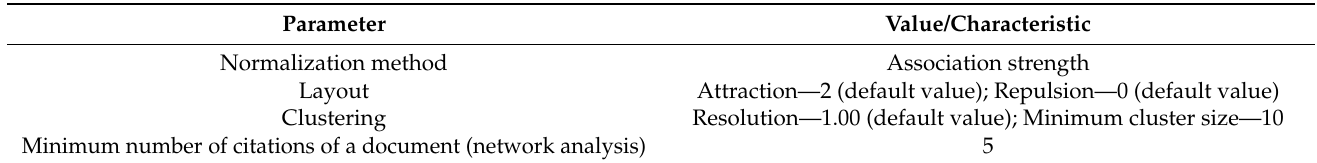
Table 1. VOSviewer